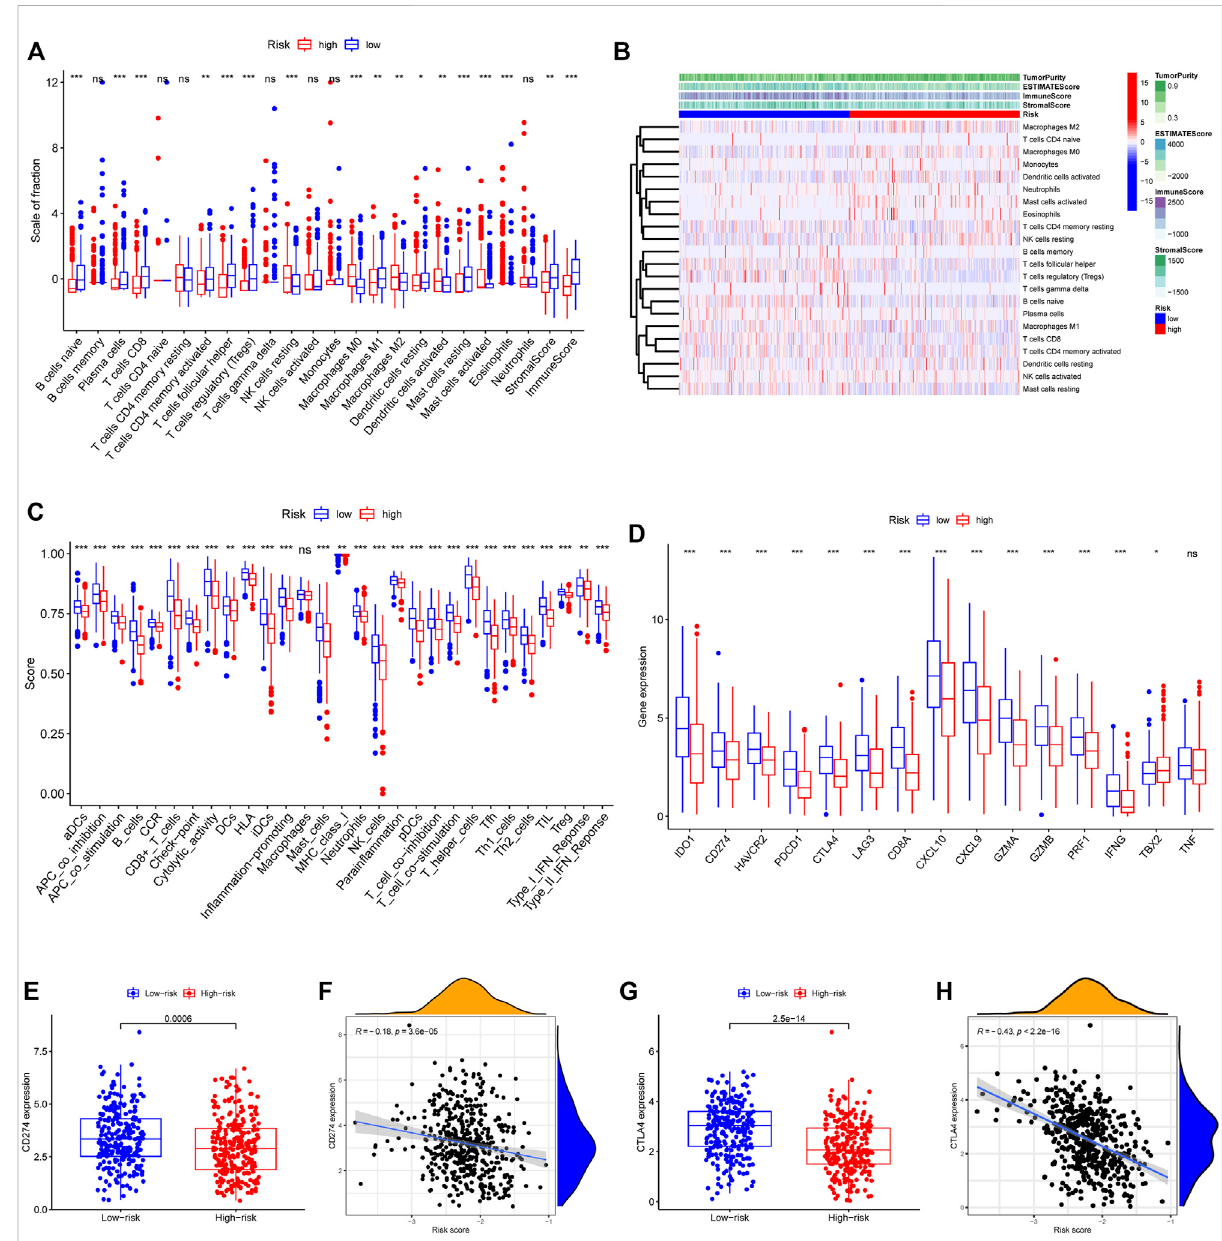
FIGURE 13 Patterns of immune cells in fi ltration in two risk groups. (A) The box plot showing the fractions of 22 in fi ltrating immune cells and immune- related scores based on CIBERSORT and ESTIMATE algorithms. (B) A heatmap presenting the 22 immune cells in the two risk score subgroups with differentimmune-related scores. (C) The ssGSEAscores for 29immunegene sets. (D) Differential expressions of the15 immune checkpoint-related genes. (E) CD274 expression difference among the high- and low-risk groups ( p = 0.0006). (F) The spearman correlation plot between CD274 expression and risk score (r = − 0.18, p = 3.6 e-05). (G) CTLA4 expression difference among the high- and low-risk groups ( p = 2.5 e-14). (H) The spearman correlation plot between CTLA4 expression and risk score (r = − 0.43, p < 2.2 e-16). p p < 0.05; pp p < 0.01; ppp p < 0.001; ns: no signi fi